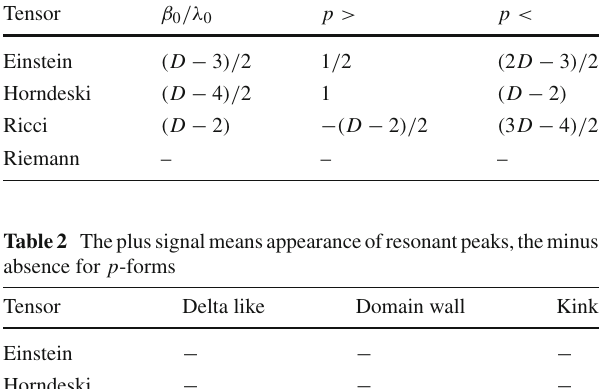
Fig. 13 The transmission coefficient for a p -form field in a brane scenario generated by a kink with D = 10 and p = 3 as function of E = m 2 For Ricci, Einstein and Horndeski couplings. b For Riemann coupling